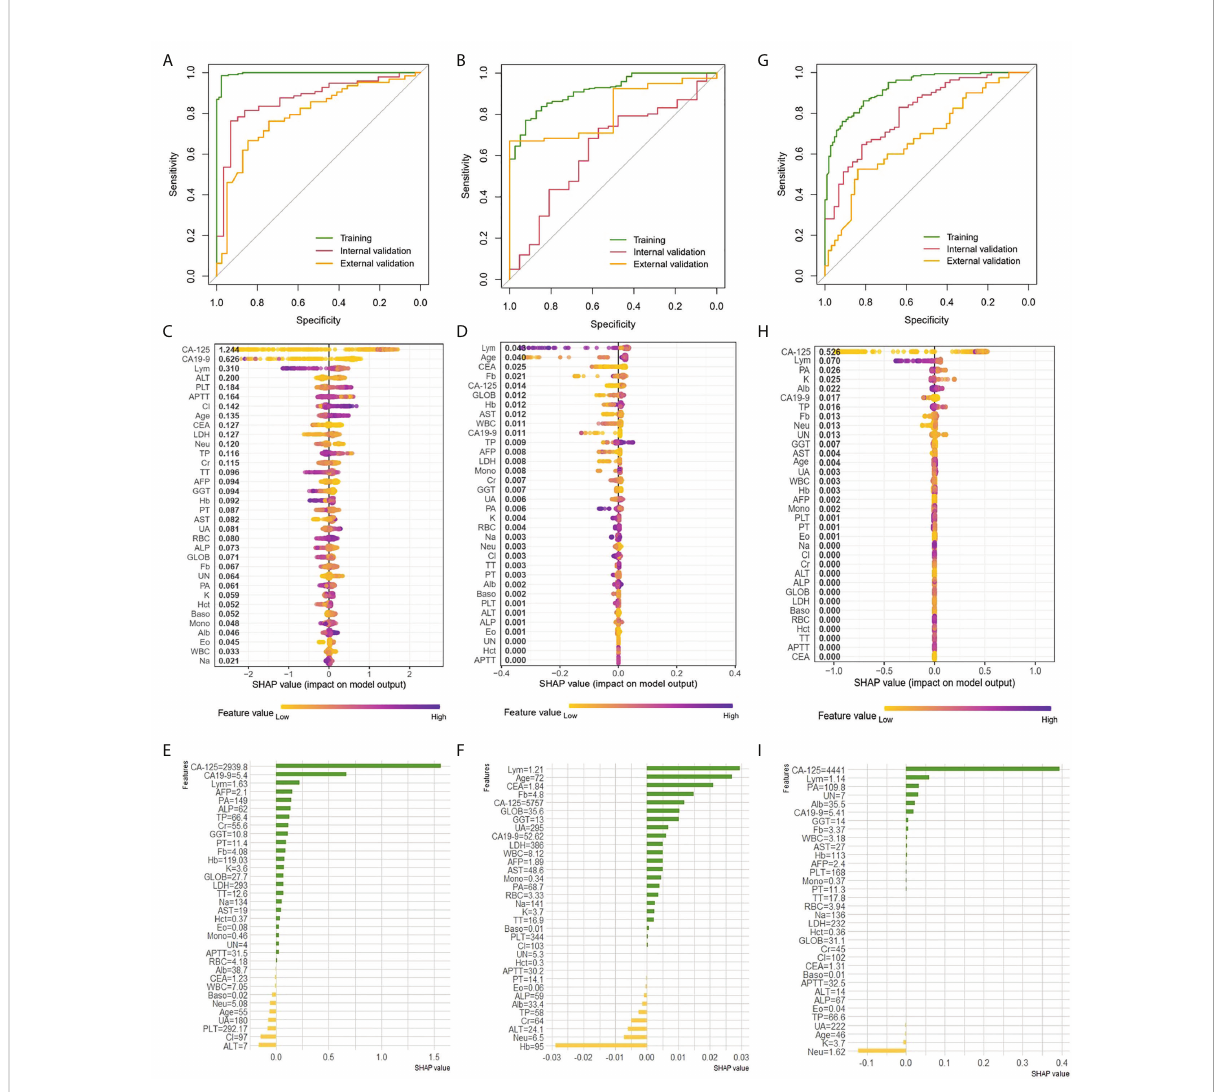
FIGURE 3 Prediction of histologic types, grade and clinical stage of EOC with XGBoost classi fi er A, B and G, ROC curve of the histologic types (A) , grade (B) and clinical stage (G) outcome in the training and validation cohorts. ( C, D,H) Features ranking interpretation of the XGBoost model for predicting the histologic types (C) , grade (D) and clinical stage (H) . ( E, F, I ) Using SHAP to observe XGBoost model for predicting individual histologic types (E) , grade (F) and clinical stage (I)